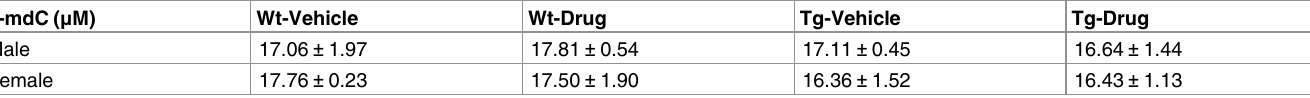
5-mdC levels of male groups: No significance was found regardless of treatment or genotype. 5-mdC levels of female groups: Wt-females had no significant difference regardless of treatment or genotype. No gender effect was found in urine 5-mdC levels among these animals. All data are expressed as Mean ± SEM, N = 5